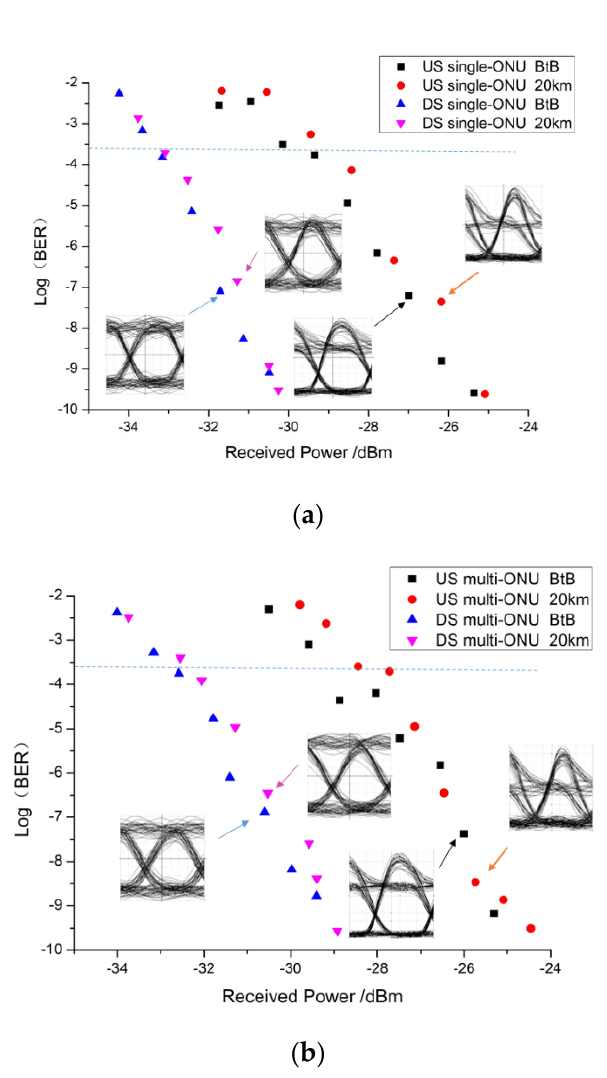
Figure 4. The BER against the received power in 10 Gb/s bidirectional transmission: ( a ) single − ONU bidirectional transmission; ( b ) multi − ONU bidirectional transmission.